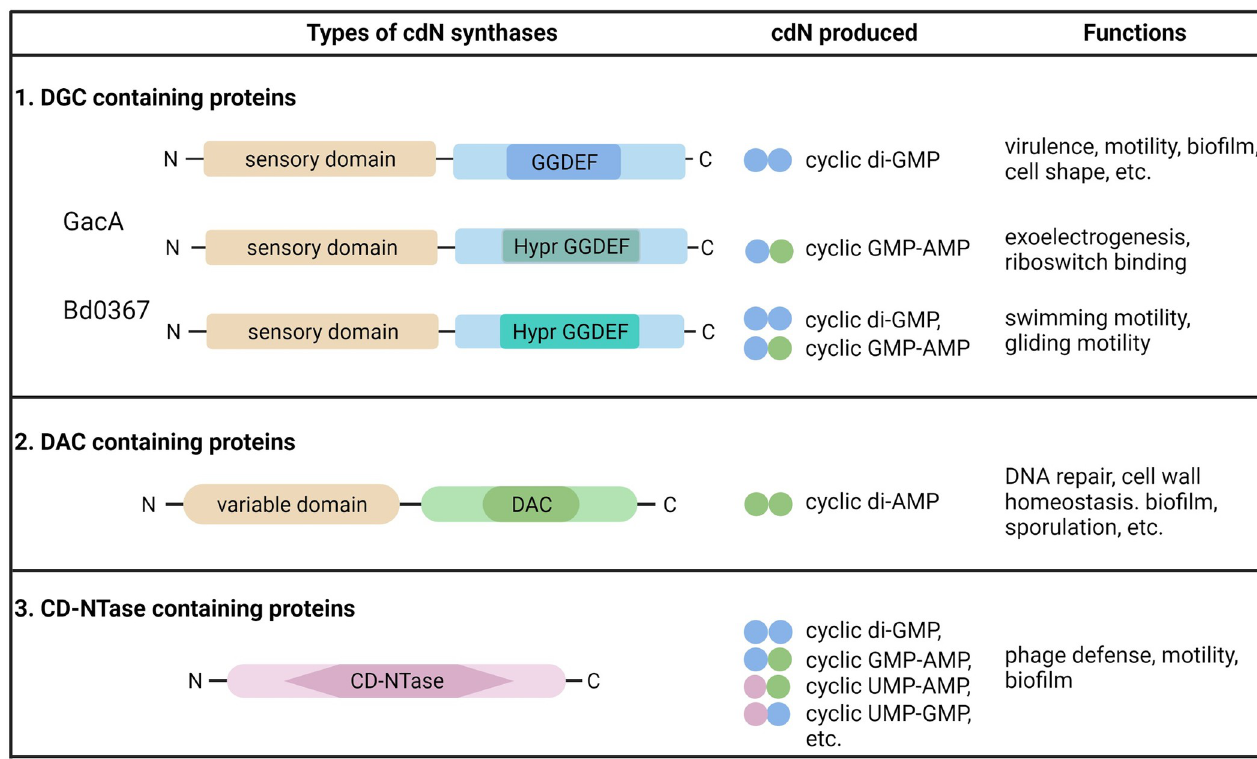
Fig 1. The 3 families of cdN synthases, the cdNs they produce, and their functions. CD-NTase, cGAS/DncV-like nucelotidyl transferase; cdN, cyclic di- nucleotide; DAC, diadenylate cyclase; DGC, diguanylate